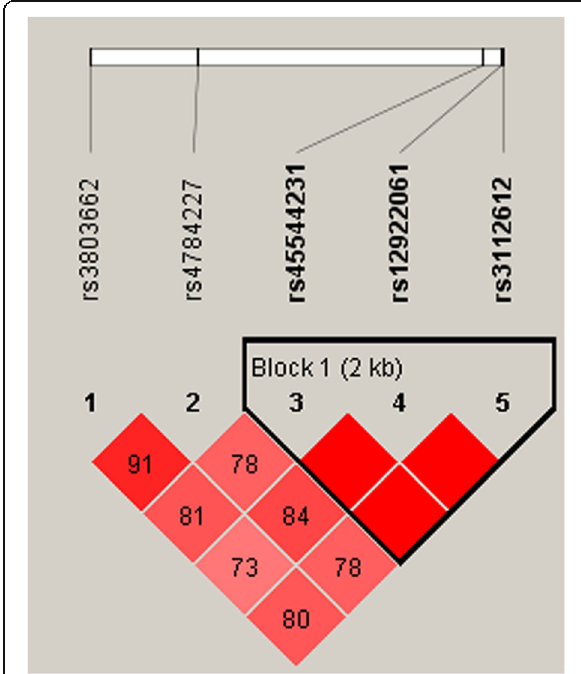
Fig. 1 Haplotype block map for SNPs of CASC16. The numbers inside the diamonds indicate the D ′ for pairwise analyses